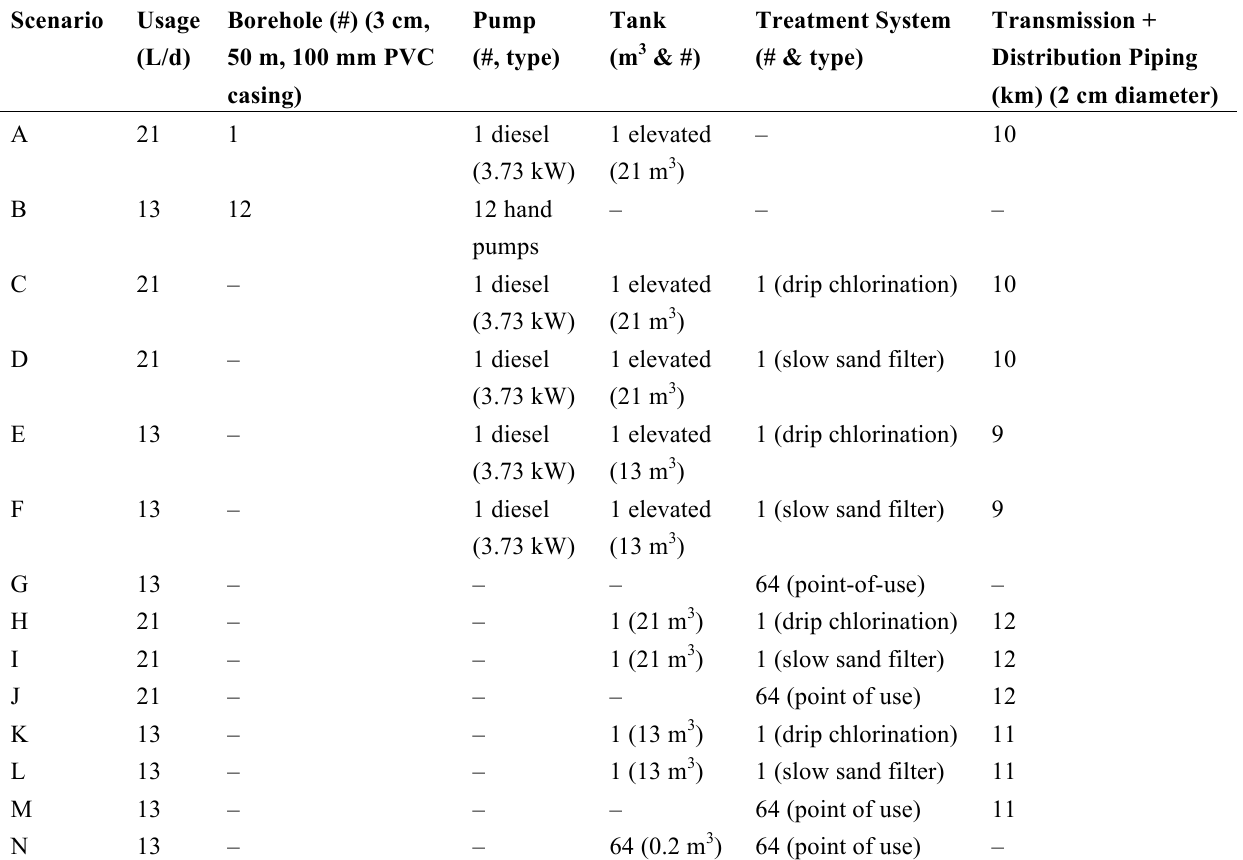
Table 5. Infrastructure assumptions for water system scenarios (taps, wash basins, valves, spring boxes, and other appurtenances are not